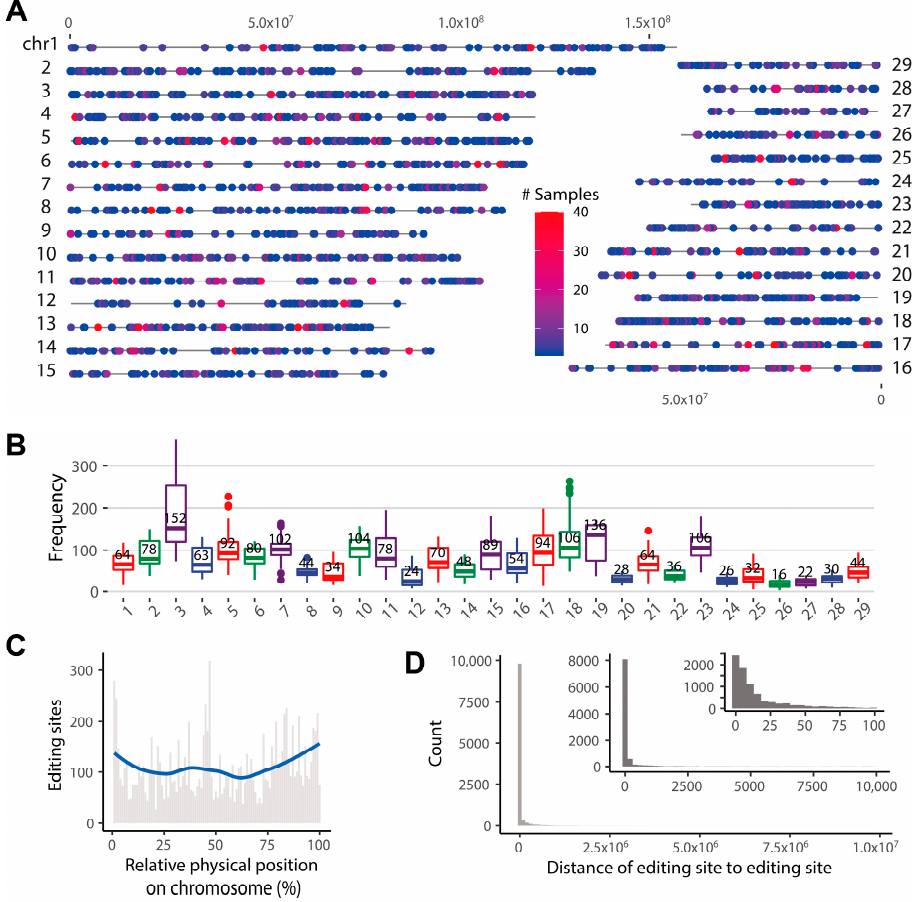
Figure 1. Characteristics of RNA editing sites (RESs) across goat genome. ( A ) Genome distribution of RESs. ( B ) Frequency distribution of RESs across the chromosomes. ( C ) Location distribution of RESs on chromosomes. ( D ) The count of RESs of the distance from editing site to editing site.